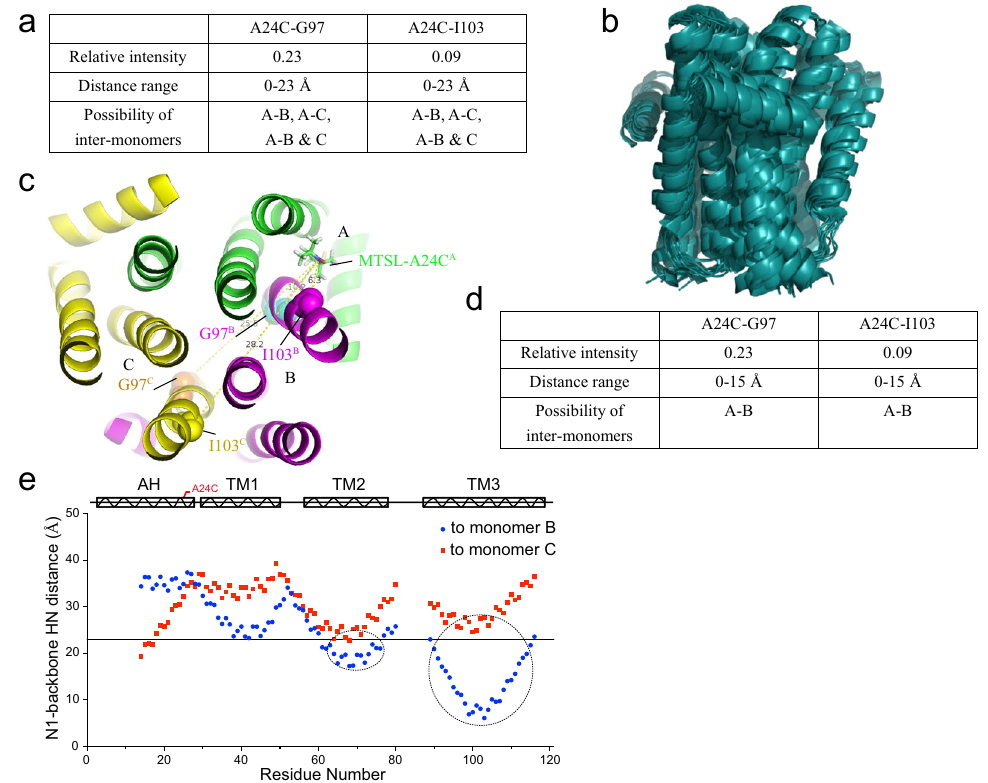
Fig. 5 Unambiguous assignment of inter-monomer PRE restraints by an iterative approach using restraints of A24C-G97 and A24C-I103 as examples. a Ambiguous inter-monomer PRE restraints of A24C-G97 and A24C-I103 from undiluted A24C MTSL-labeled sample. b The 10 lowest energy preliminary structural ensembles calculated by using all the unambiguous intra-monomer PRE restraints and ambiguous inter-monomer restraints in PRE-CS-Rosetta calculation. c As measured in the lowest energy structural model, the distances of electron-H N from A24C A to G97 B and I103 B are 10.2 and 6.3 Å, respectively, while to G97 C and I103 C are 28.2 and 25.5 Å, respectively. Therefore, the possibilities of inter-monomer PRE effects of A-C and A-B&C monomers can be excluded. d Inter-monomer PRE restraints of A24C-G97 and A24C-I103 were unambiguously assigned, and the distance range was reduced from 0 – 23 Å to 0 – 15 Å. e Distances between the nitroxide radical of the A24C site in monomer A and backbone amide protons in monomers B (blue dot) and C (red dot), as measured in the primary structure model of DgkA. The straight line highlights the distance of 23 Å. The dashed circles represent the relative intensities that are lower than 0.7 in the inter-monomer PRE of the A24C site (see Fig. S14i for more details). The distances between the nitroxide radical at the A24C site in monomer A and backbone amide protons in monomer C (red dot) are almost larger than 23 Å. Hence, those possibilities of inter-monomer PRE effects of A-C and A-B&C monomers could be